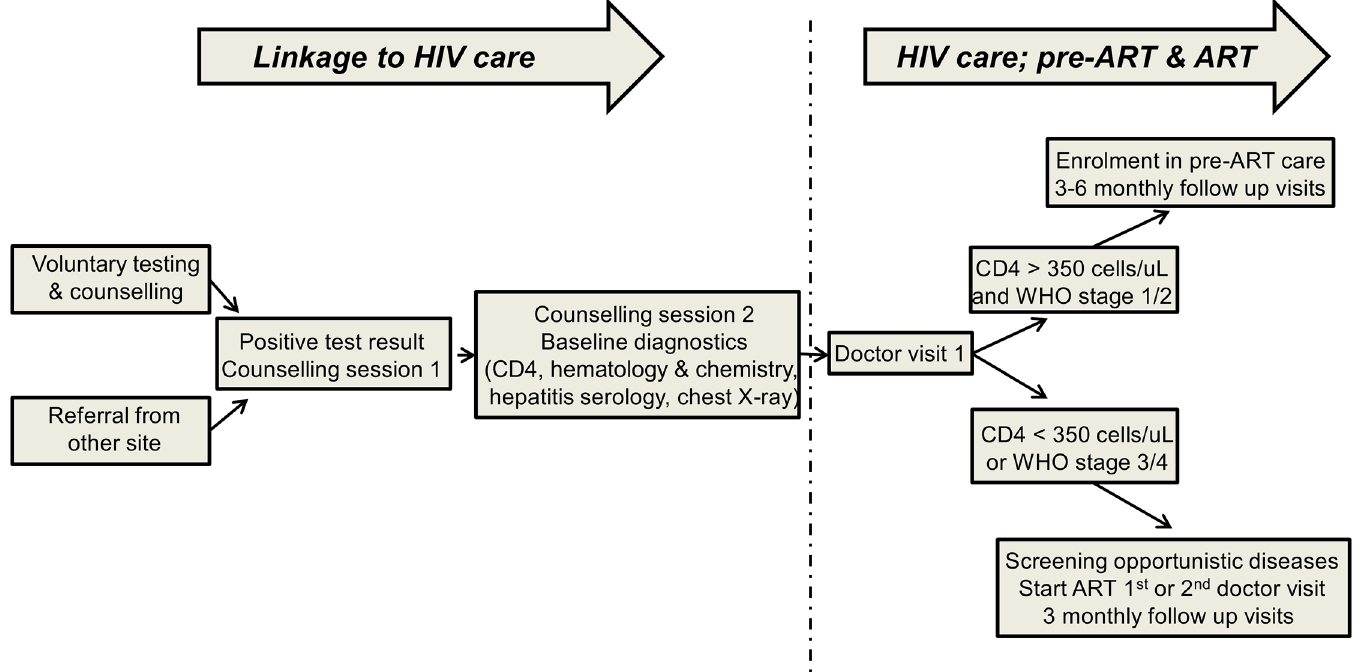
Fig 1. Clinic flow. Fig 1 shows the patient flow upon entry at the